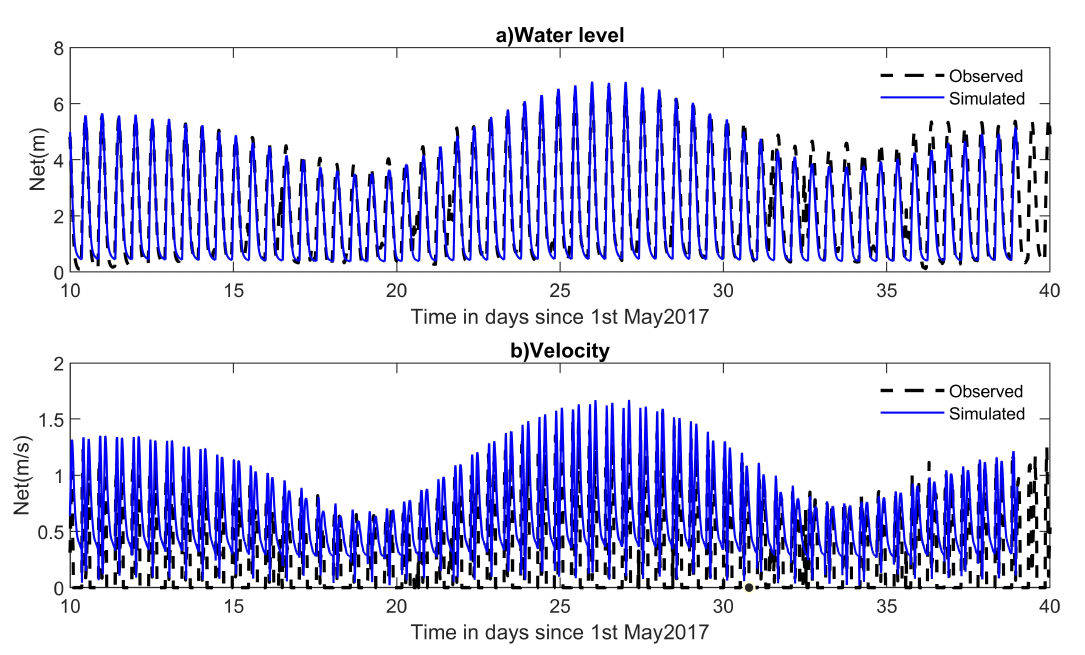
Figure 8. Results of water level ( a ) and velocity ( b ) validation at the Net